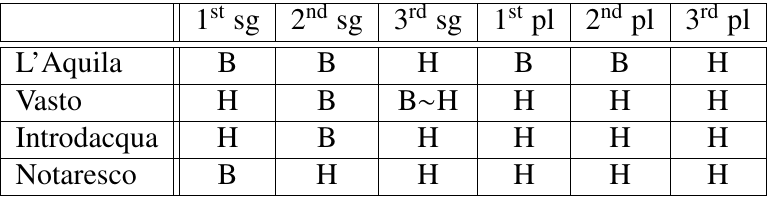
Table 1: Cross-linguistic variation in auxiliary selection in Abruzzo (Loporcaro,